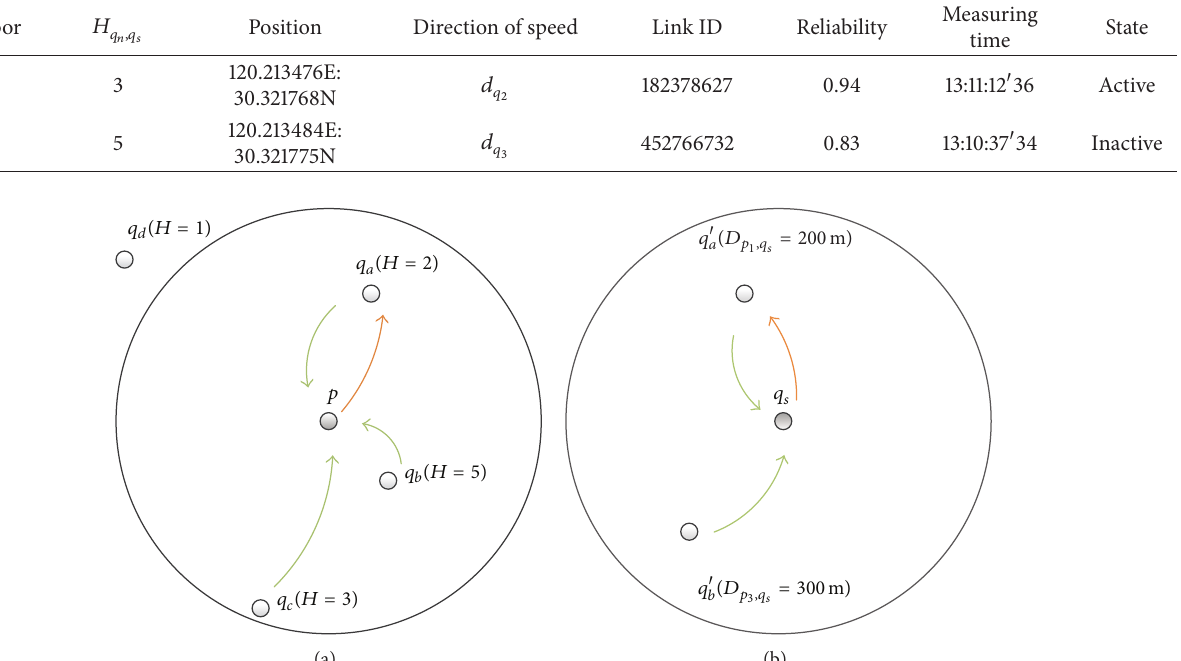
Figure 1: (a) If there are the 𝑞 nodes within the single hop range of 𝑝 , then they shake hands and choose one as 𝑞 𝑎 that has minimal hop distance to 𝑞 𝑠 to make an appointment. (b) If there are several 𝑞 nodes around 𝑞 𝑠 and several 𝑝 nodes, send the appointment requests, then they shake hands and choose the nearest 𝑝 node to response.